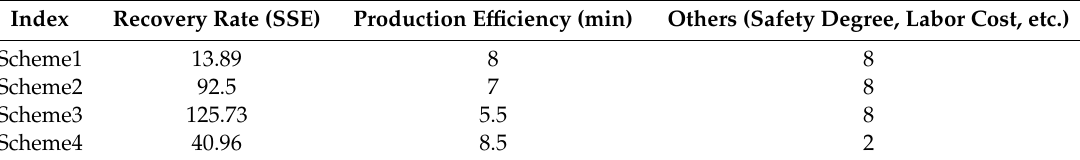
Table 2. Evaluation